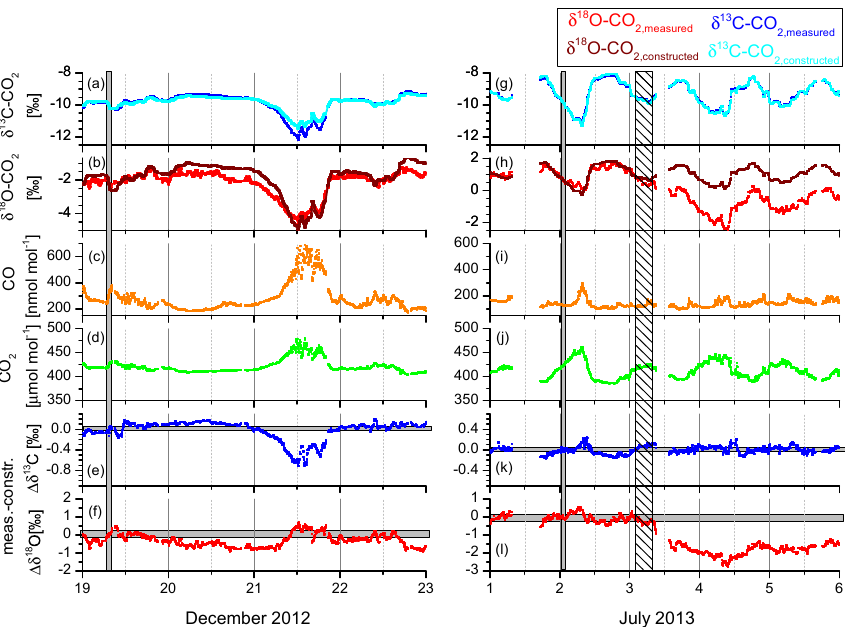
Figure 7. Trace gas records in winter (left panel) and summer (right panel) in Heidelberg. (a) and (g) show the measured (dark blue) and artificially constructed (light blue) δ 13 C-CO 2 value, (b) and (h) the measured (red) and artificially constructed (burgundy) δ 18 O-CO 2 value, (c) and (i) the measured CO value, (d) and (j) the measured CO 2 value. Panels (e) and (k) give the difference between the mea- sured and constructed δ 13 C-CO 2 value with a mean isotopic source signature of δ 13 C-CO 2 , VPDB ≈− 25‰ in the wintertime and δ 13 C- CO 2 , VPDB ≈− 27‰ in the summertime. Panels (f) and (l) give the difference between the measured and constructed δ 18 O-CO 2 value with a mean isotopic signature of δ 18 O-CO 2 , VPDB ≈− 28‰ in the wintertime and δ 18 O-CO 2 , VPDB ≈− 12‰ in the summertime. Grey vertical bars indicate the “reference periods”, in which the isotopic source signature for artificially constructed δ 13 C-CO 2 and δ 18 O-CO 2 was deter- mined from Keeling plots of about 20 individual atmospheric 3min average measurements. The dashed vertical bar in the right panel shows a period of high precipitation. Grey horizontal bars in (f) and (l) mark the 1 σ -uncertainty of the isotope